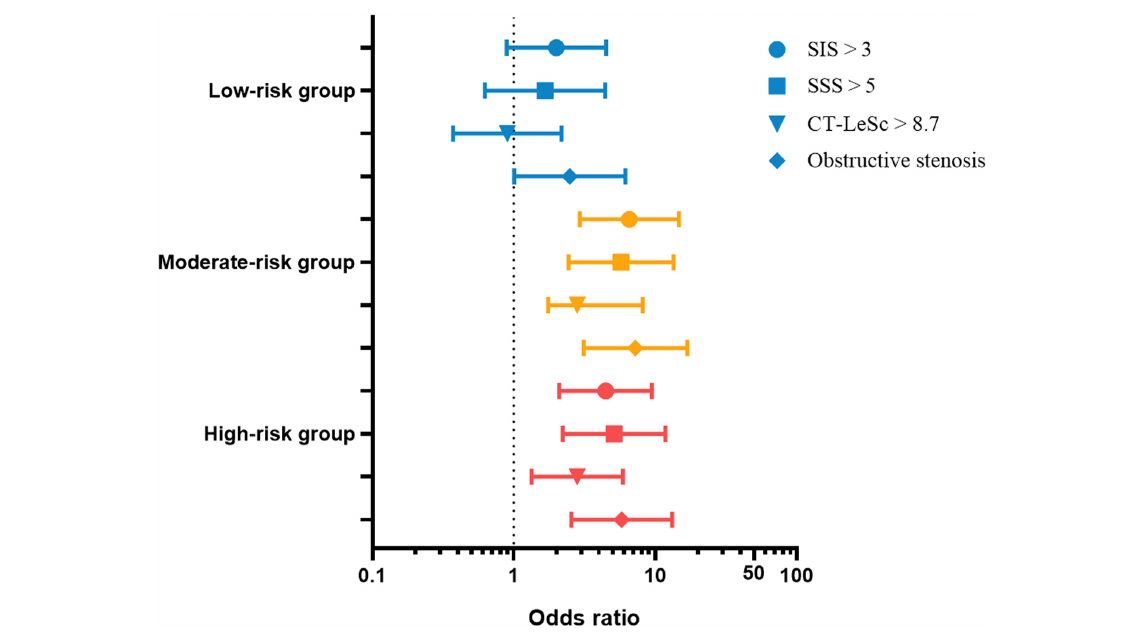
FIGURE6 The SIS > 3, SSS > 5, CT-LeSc > 8.7, and obstructive stenosis odds ratio (95% CI) of the DM group and subgroups. SIS, segment involvement score; SSS, segment stenosis score; SC, stenosis coefficient; CT-LeSc, CCTA-adapted Leaman score. The control group was used as the reference